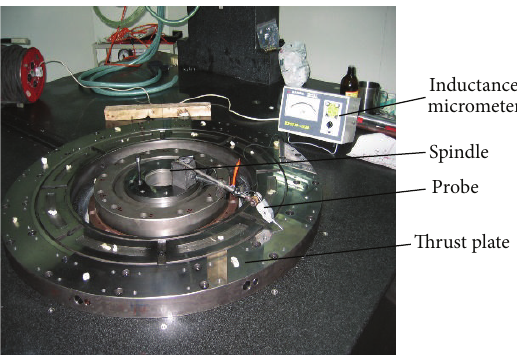
Figure 7: Measurement of squareness between guideway and spindle rotated